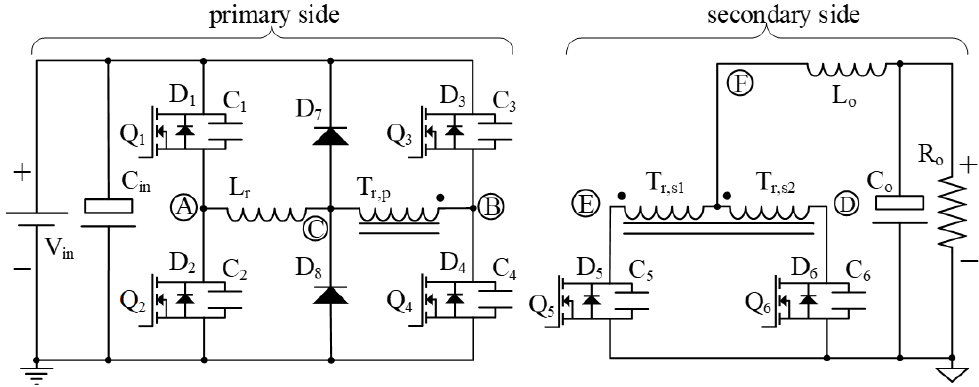
Figure 1. Phase shift full bridge (PSFB) converter with center tapped rectification stage, external resonant inductance and clamping diodes.